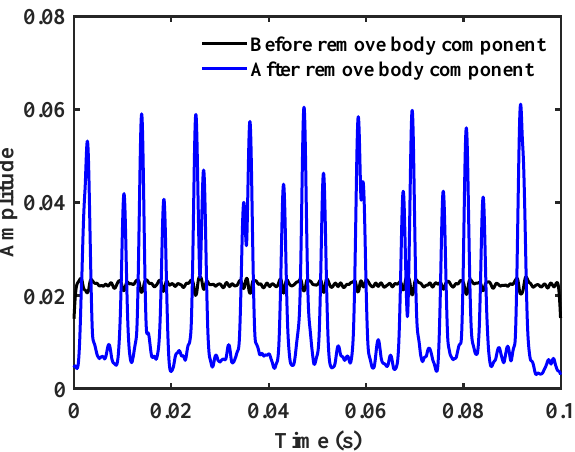
Figure 11. The first singular vector comparison before and after removal of the body component signal.